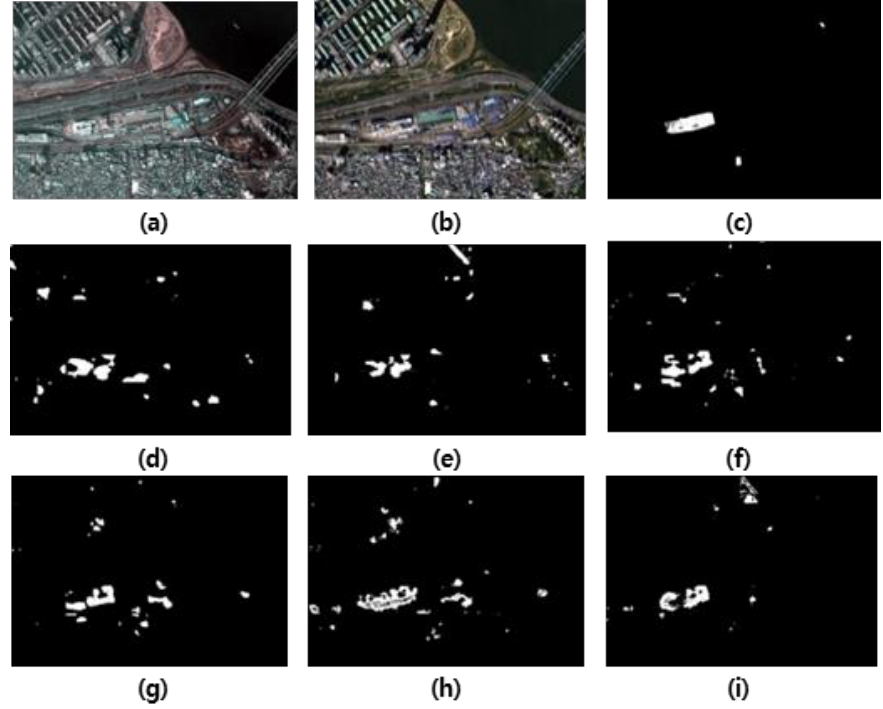
Figure 18. Changed detection maps of the proposed and conventional algorithms for “Test area 4”: ( a ) Image P; ( b ) Image C; ( c ) Ground truth; ( d ) DI + UNet; ( e ) DI + ATTUNet; ( f ) JF + UNet; ( g ) JF + ATTUNet; ( h ) Modified-UNet++; ( i ) Proposed bilateral U-Net.